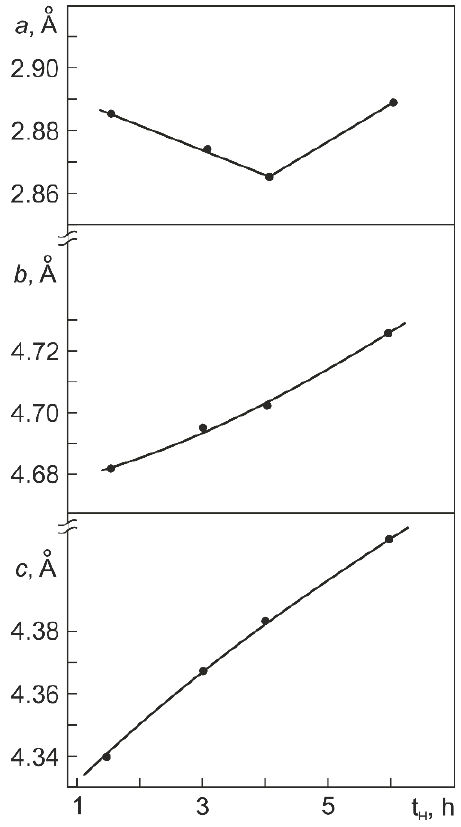
Figure 8. Lattice parameters(a, b and c) of orthorhombic hydride (analogue of β 1 -TiFeH 0.94 ) vs. hydrogenation time t H in normal saline at 20 A/m 2 .